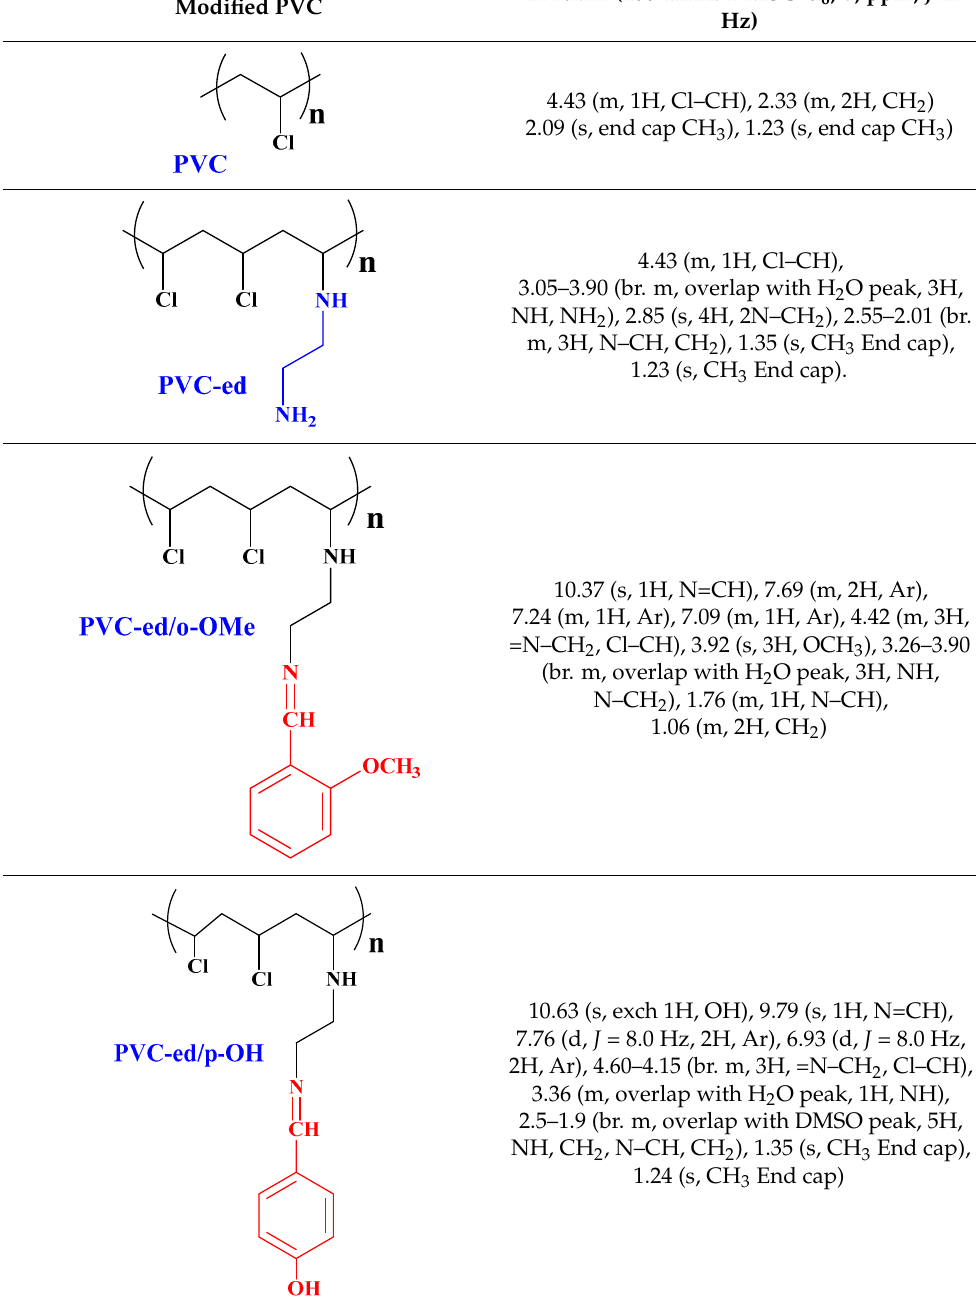
Table 1. 1 H NMR peaks of synthesized modified PVC.